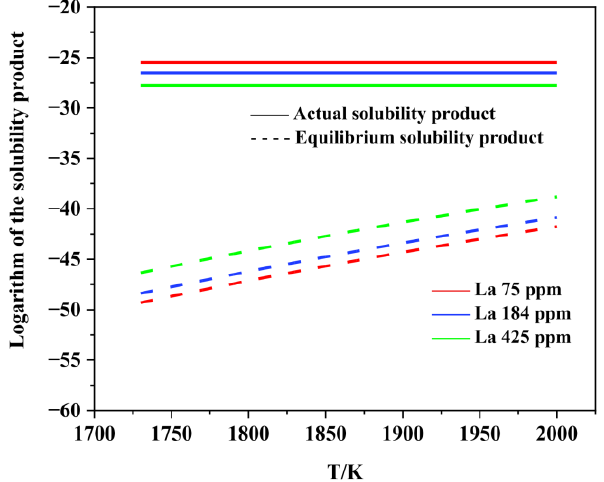
Figure 8. Logarithm of the solubility product as a function of temperature for LaAlO 3 in liquid steel.